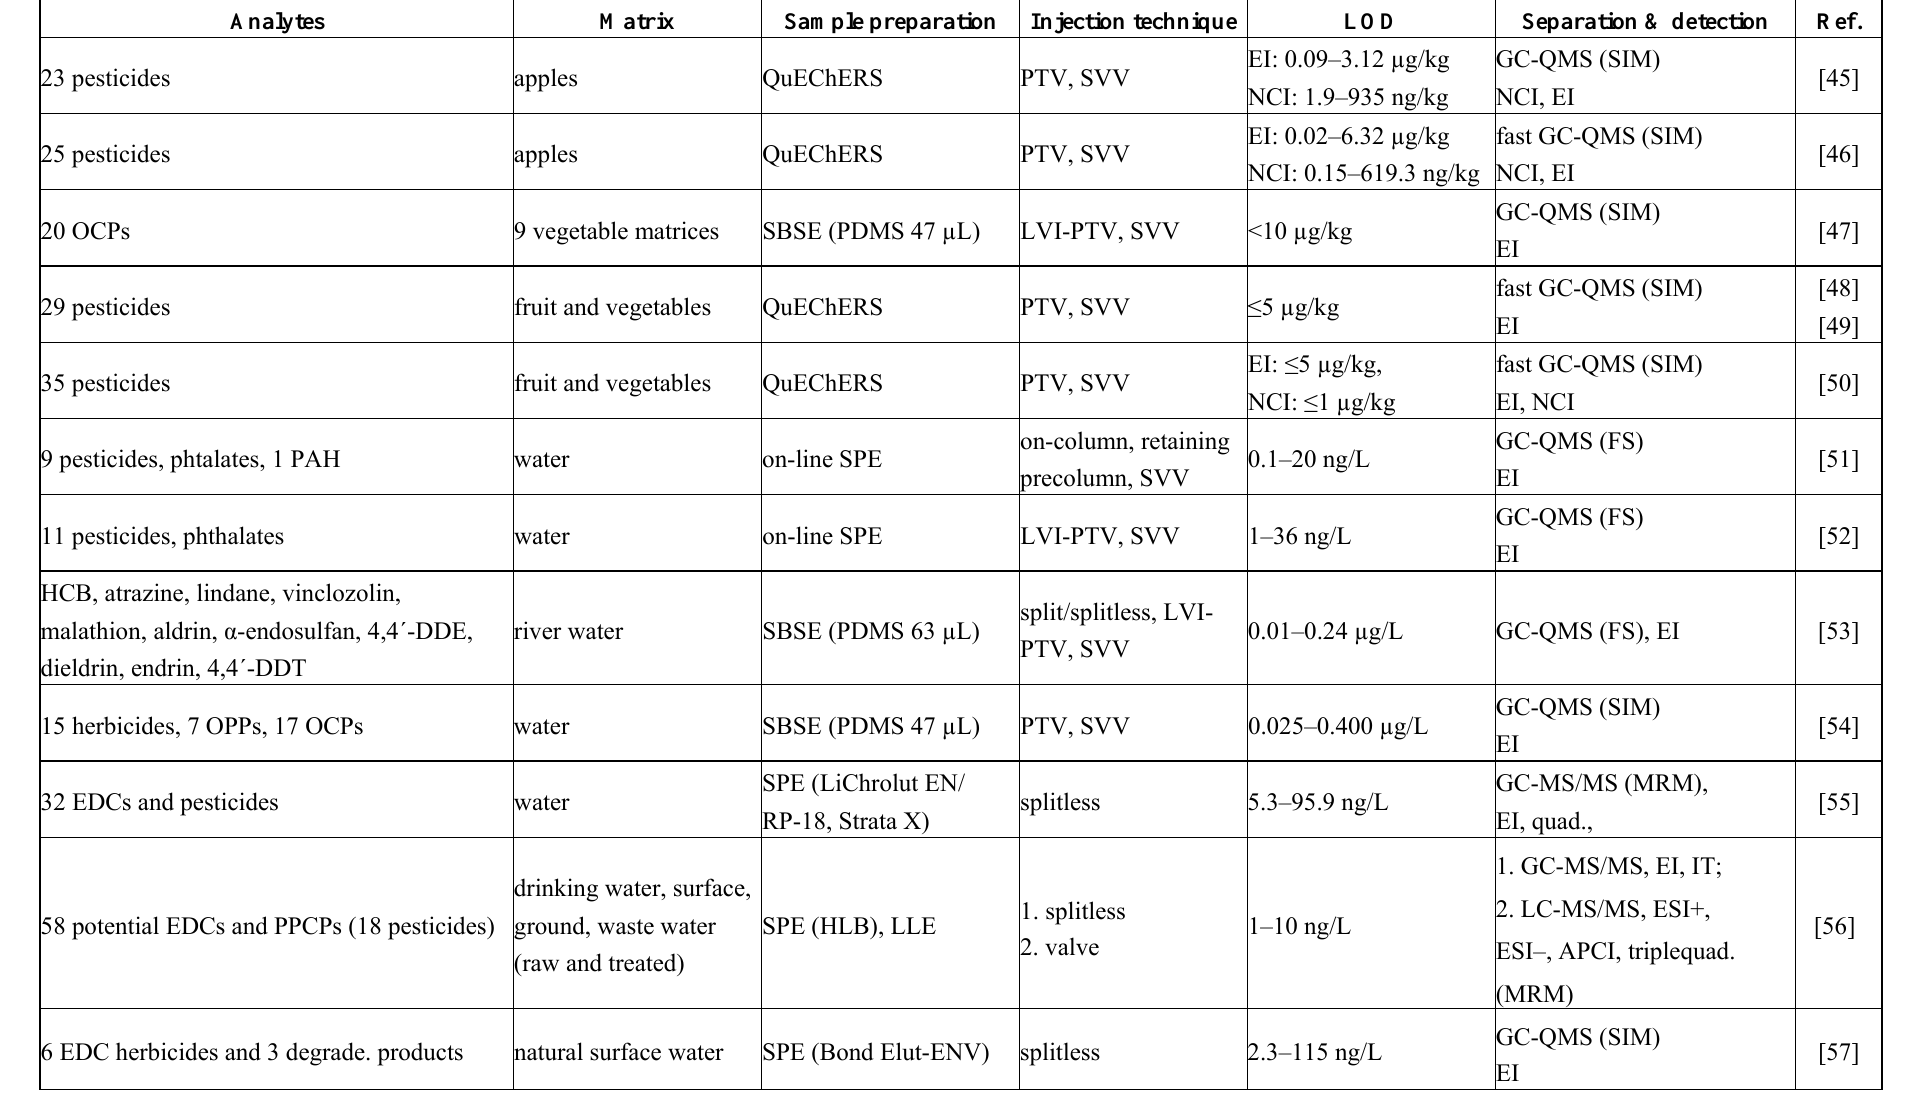
Table 4. An overview of analytical methods for analysis of EDPs alone and with other groups of